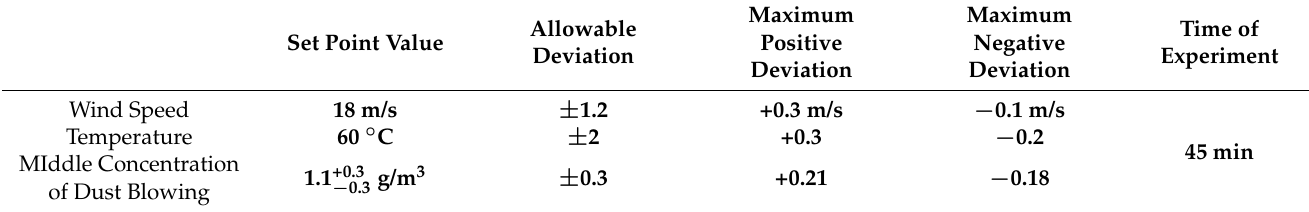
Table 5. Commissioning Results of 18 m/s Wind Speed, High Temperature and Medium